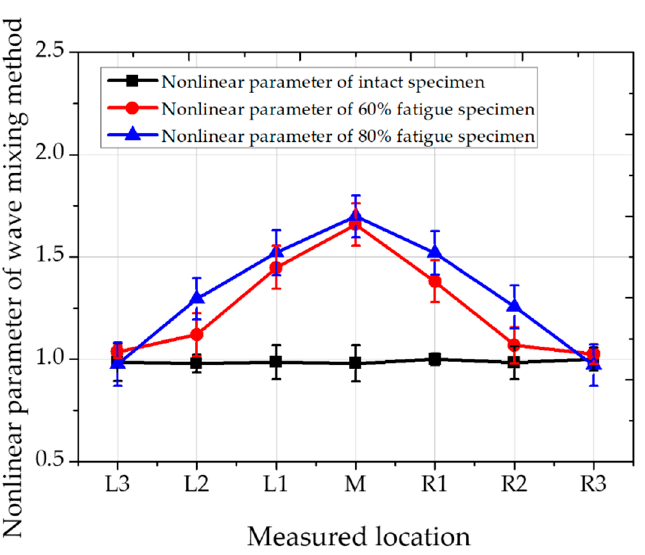
Figure 10. Wave mixing for measuring nonlinear parameter at various positions.